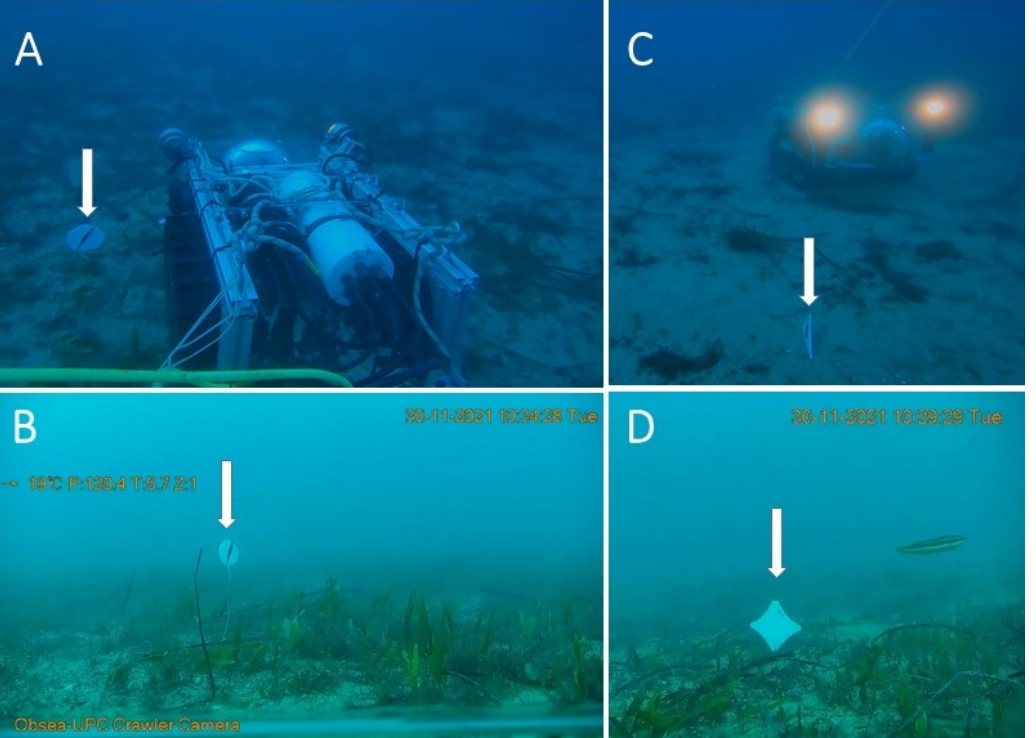
Figure 11. The crawler’s automatic navigation test at the OBSEA facility, showing the platform approach to the plastic tags (indicated by the white arrows): ( A ) the crawler approaching a circle tag and ( B ) the imaging of the tag within the crawlers’ FOV; ( C ) the crawler approaching another rhomboidal tag (sharp lateral vision) and ( D ) the same spoing of the rhomboidal tag within the crawlers’ FOV. One should notice the high rendering of the crawler camera (plates ( B ) and ( D )) in relation to the ROV camera (plates ( A ) and ( C ), a different camera type and model).